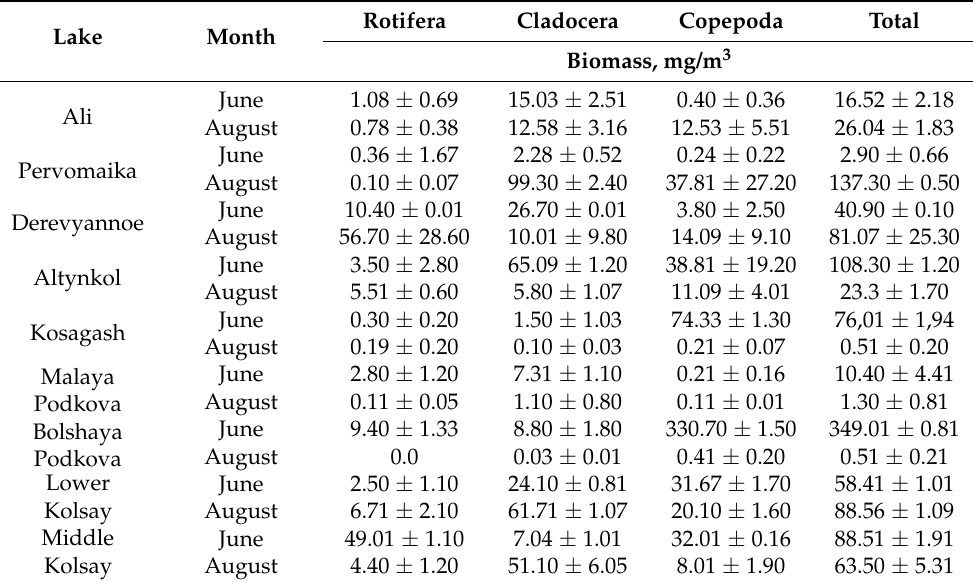
Table 8. Zooplankton biomass in small lakes of South-East Kazakhstan, mean values with standard deviation, summer